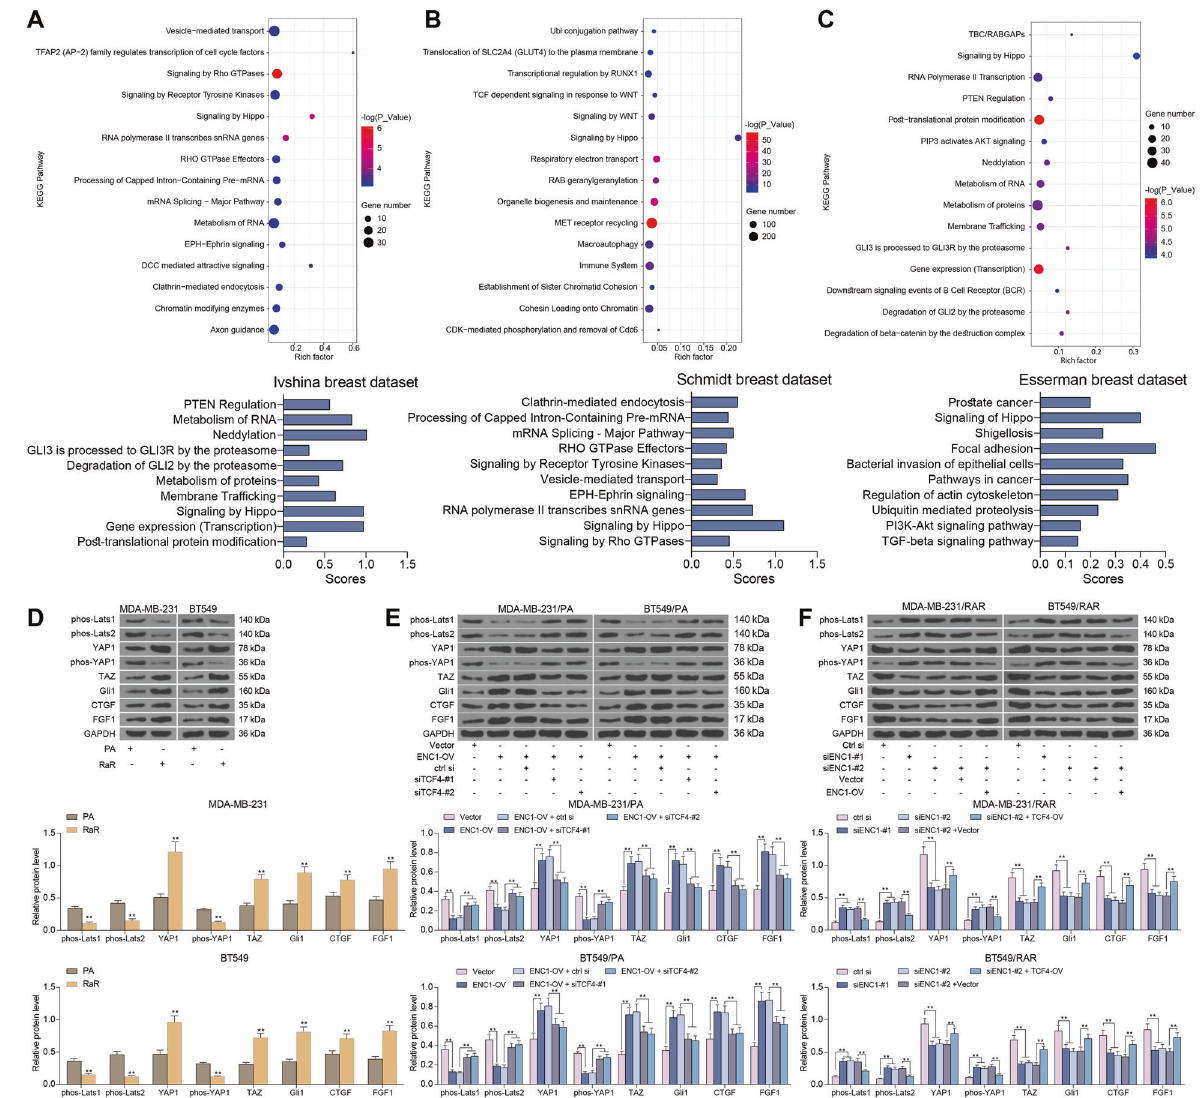
Fig. 7 ENC1 promotes radio-resistance in BC cells by activating the Hippo signaling pathway. A – C Ivshina breast cancer dataset ( A ), the Schmidt breast dataset ( B ), and the Esserman breast dataset ( C ) were accessed from the Oncomine database, and correlation analyses with ENC1 expression were performed to collect Spearman correlation coef fi cients. Genes greater than 0.45 were subjected to reactome signaling pathway enrichment analysis. D – F Western blot detection of phosphorylation levels of Lasts 1/2, YAP1 and TAZ, and expression of Gli1, CTGF and FGF1 in untreated MDA-MB-231 and BT549 cells ( D ), MDA-MB-231/RA and BT549/RA cells ( E ) and MDA-MB-231/RaR and BT549/RaR cells ( F ). Data are representative of 3 separate experiments performed in triplicate. All the data are expressed as the mean ± SD. Two-way ANOVA with Tukey ’ s multiple comparison test were utilized to detect signi fi cant differences between data. ** p <